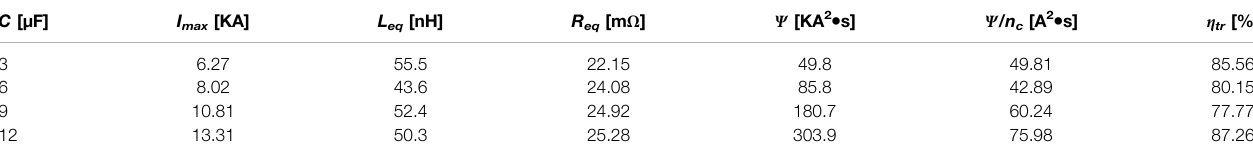
TABLE 4 | APPT discharge parameters at different capacitances.